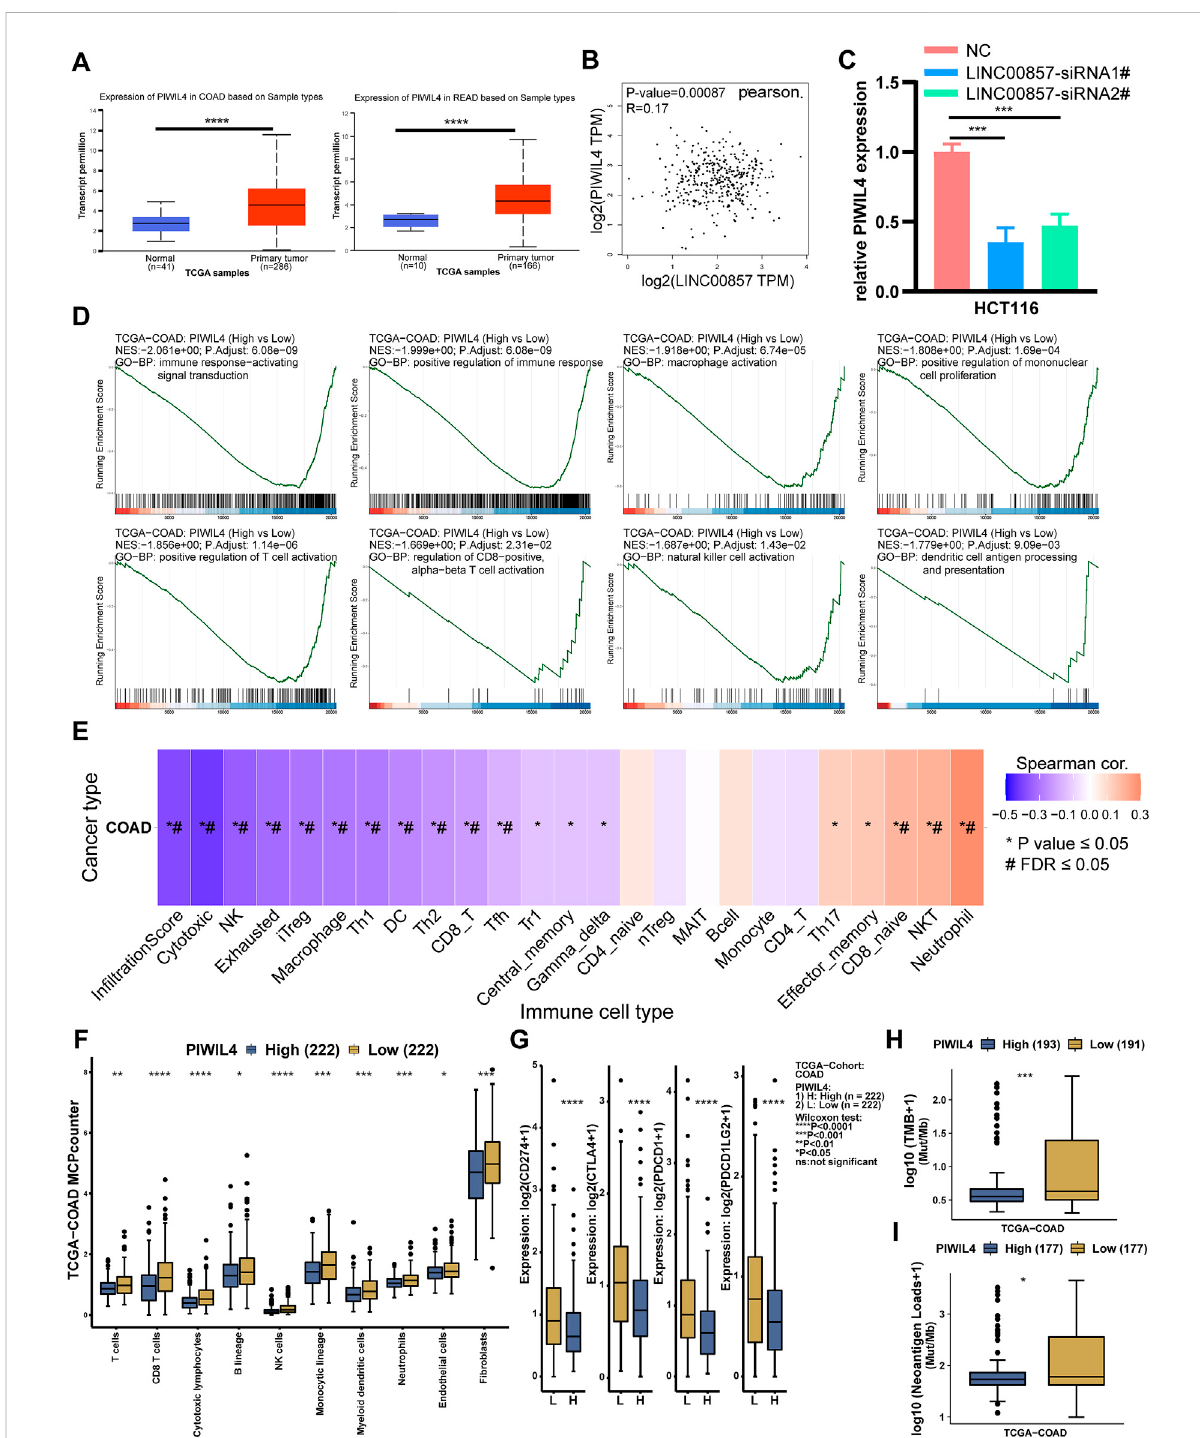
LINC00857 regulated the expression of PIWIL4 in colorectal cancer. (A) PIWIL4 expression in colorectal cancer samples and normal samples was explored via UALCAN database. (B) The relevance between LINC00857 and PIWIL4 expression in colorectal cancer was explored via GEPIA2database. (C) TheexpressionofPIWIL4mRNAafterLINC00857silencingwasdetermined via qPCRassay. (D) GSEAoftherelevancebetween PIWIL4 expression and immune response pathways in COAD. (|NES| > 1, p adjust < 0.05) (E) The correlation between GSVA score and immune in fi ltration in colon cancer. (* p value < 0.05, #FDR < 0.05). (F – I) Differences of immune cell in fi ltration levels, immune checkpoint genes expression levels, TMB and NEO status between PIWIL4 high and low expression